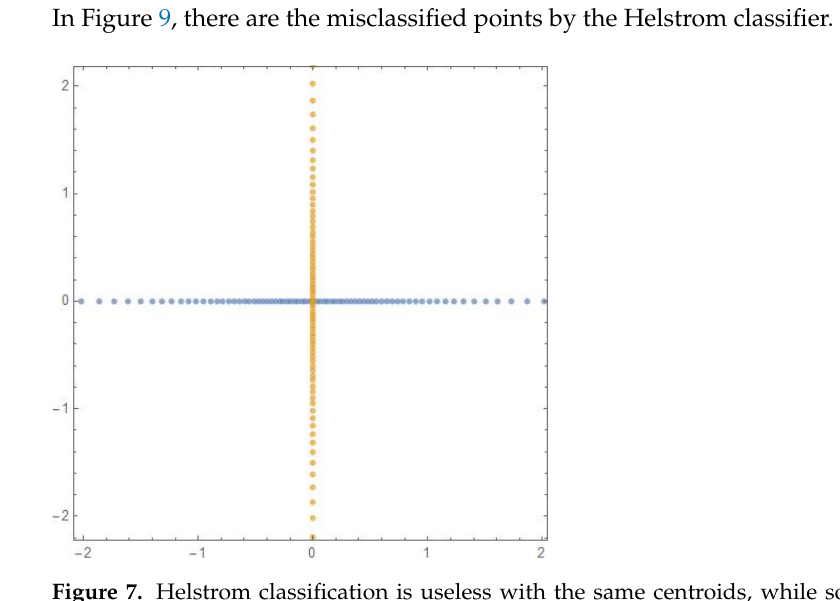
Figure 7. Helstrom classification is useless with the same centroids, while some classical meth- ods